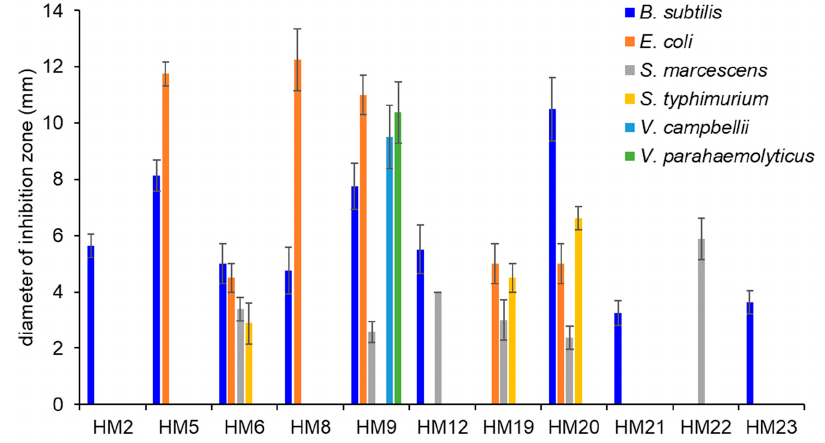
Figure 6. Antimicrobial activities of sponge-associated bacteria. Table 3. Classification of antibiotic producing strains (Notation: ND, not detected; NRPS, non-ribosomal peptide synthetases; PKSII, polyketide synthases II; the letters A, B, C, D, E, and F denote types of antimicrobial patterns against Bacillus subtilis , Escherichia coli , Serratia marcescens , Salmonella typhimurium , Vibrio campbellii , and Vibrio parahaemolyticus , respectively).